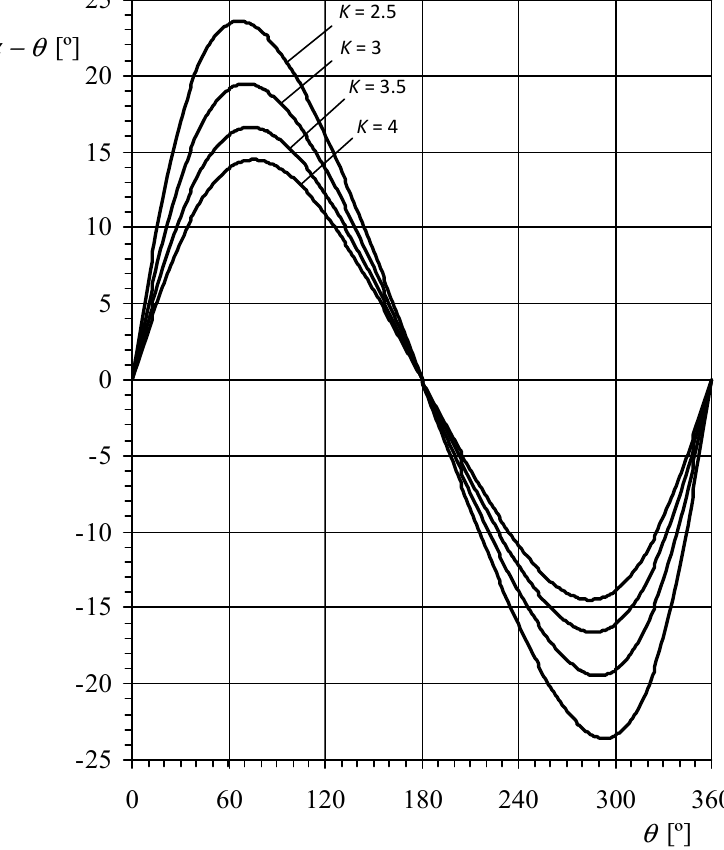
Figure 3. Difference between the local wind angle with respect to the cup (commonly known as angle of attack), α , and the anemometer rotor’s rotation angle, θ , as a function of the latter, for different anemometer factors, K . See also the sketch included in Figure